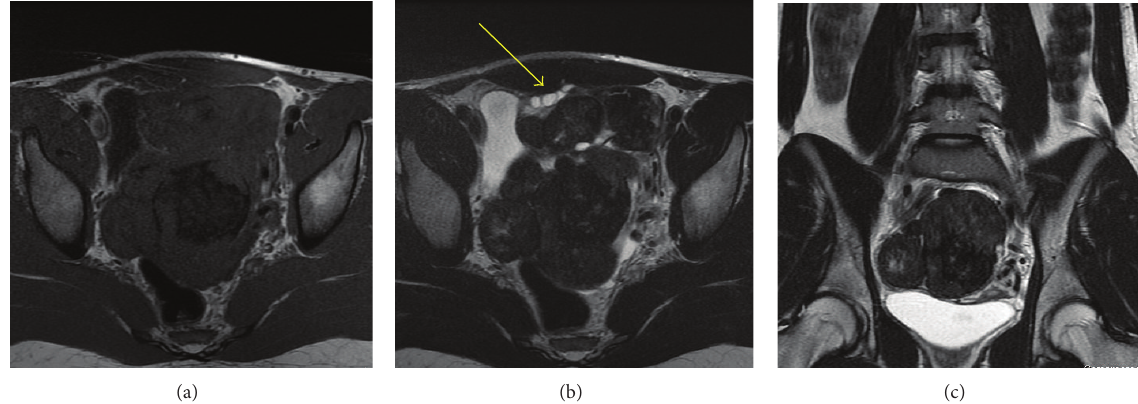
Figure 2: MRI imaging. (a) Axial T1-W image through the pelvis shows 1 contiguous or multiple soft tissue pelvic masses demonstrating isointense T1 signal when compared with normal muscle and a hypointense central component that represents the fibrous portion of the mass. (b) Axial T2-W image demonstrates multiple normal ovarian follicles within the anterior portion of the mass ( yellow arrow ), localizing the pelvic mass to the ovary. (c) Coronal T2-W image demonstrates heterogeneous solid masses predominately intermediate to low intensity T2